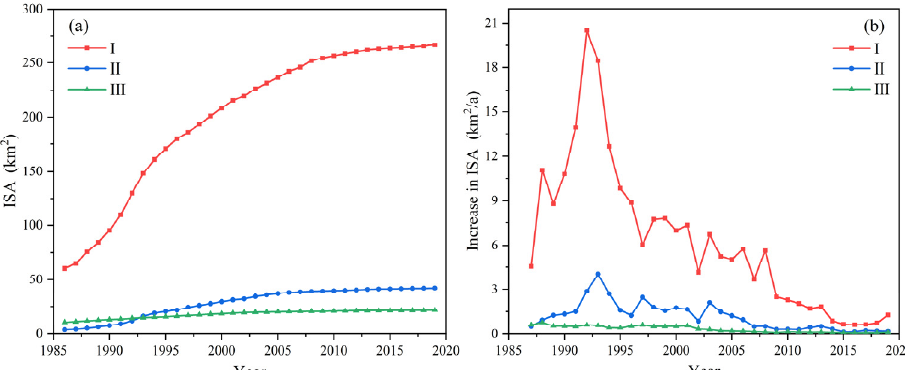
Figure 7. Inter-annual changes of ( a ) the ISA and ( b ) the increase in ISA within the monitoring areas ( I , II , and III ).